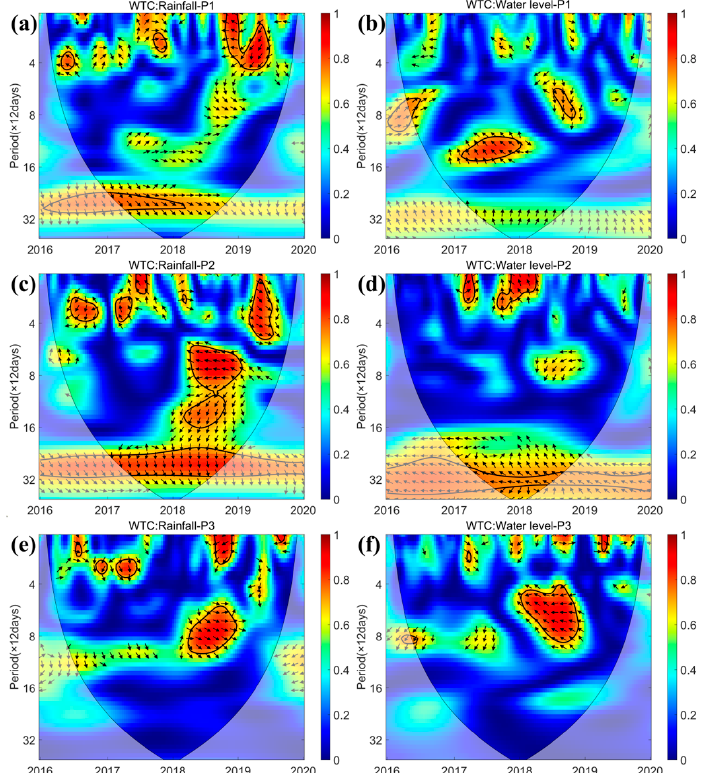
Figure 13. WTC results for different time series data: ( a , c , e ) denote the cross-wavelet energy spectra of precipitation and nonlinear deformation feature points p1, p2 and p3, respectively; ( b , d , f ) denote the cross-wavelet energy spectra of reservoir water level and nonlinear deformation feature points p1, p2 and p3, respectively.